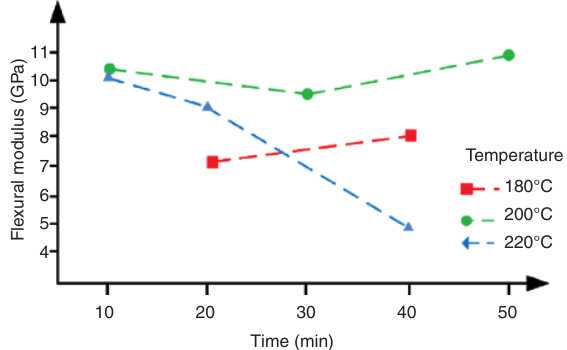
Figure 8: The interaction effect of processing time and temperature on the flexural modulus of the